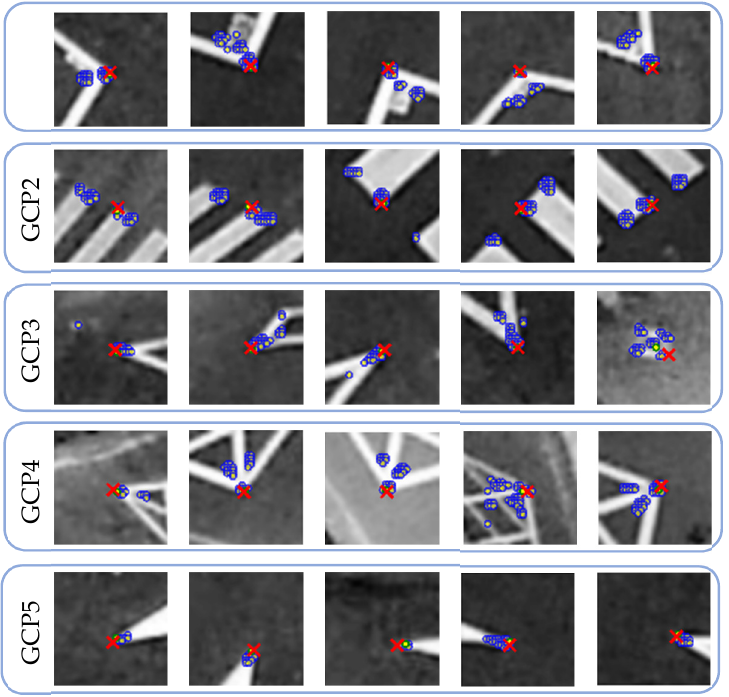
Figure 10. The GCP pixels positioning results (five samples for each GCP are displayed): The blue circle marks represent the corner pixels obtained by corner detection; The green circle marks represent the candidate pixels for the target GCPs; The red crosses represent the final sub-pixel position of the target GCPs.